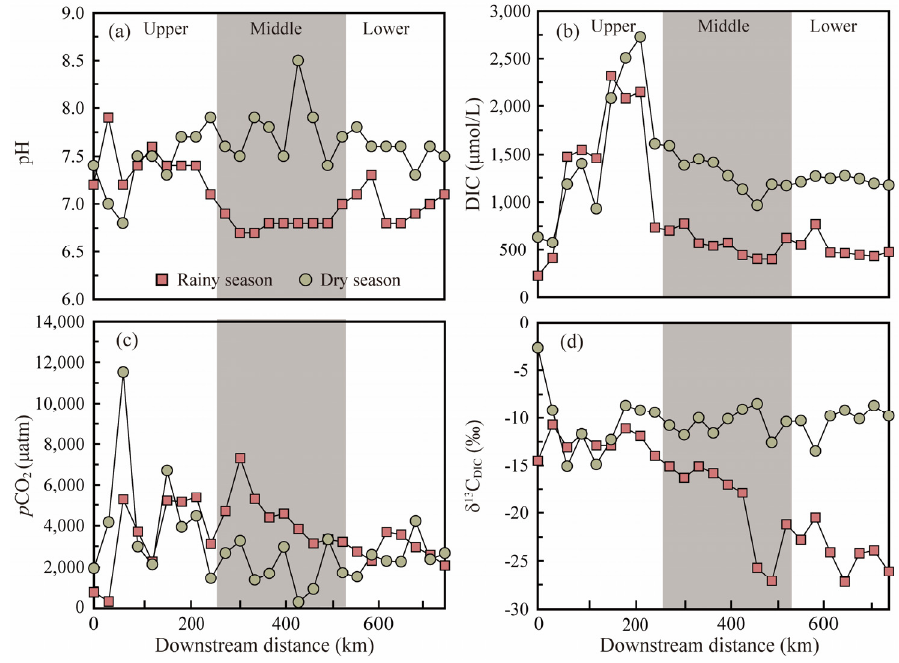
Figure 4. The Spatio-temporal variation characteristics of ( a ) pH, ( b ) DIC, ( c ) p CO 2 and ( d ) carbon isotopes along the mainstream.